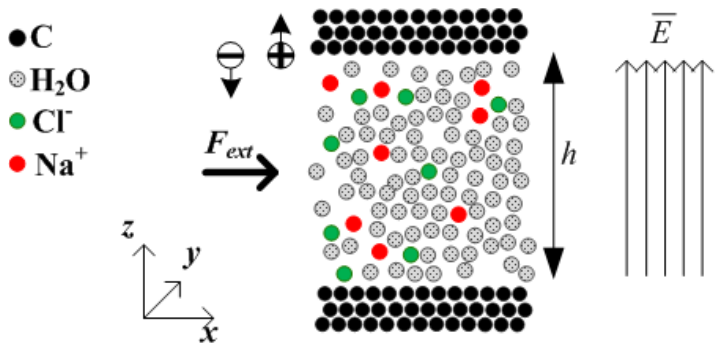
Figure 1. Simulated channel model with water and ions flowing among carbon walls. The direction of the electric field applied is perpendicular to the external driving force. Table 1. Model details. Channels of height h = 1.5–13.5 nm are incorporated. L i is the length of simulation box in each dimension ( i = x , y , or z ), a: the clean water region shown in Figure 2, N H2O and N C : the number of H 2 O molecules and carbon atoms, respectively.